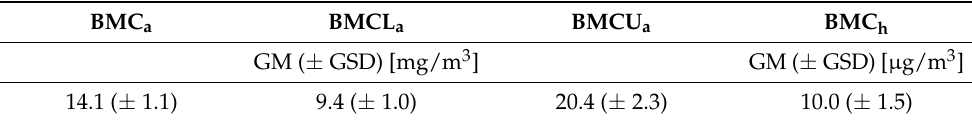
Table 1. BMC a , BMCL a , BMCU a (GM ± GSD; mg/m 3 ) and BMCh (GM ± GSD) calculated for carbon